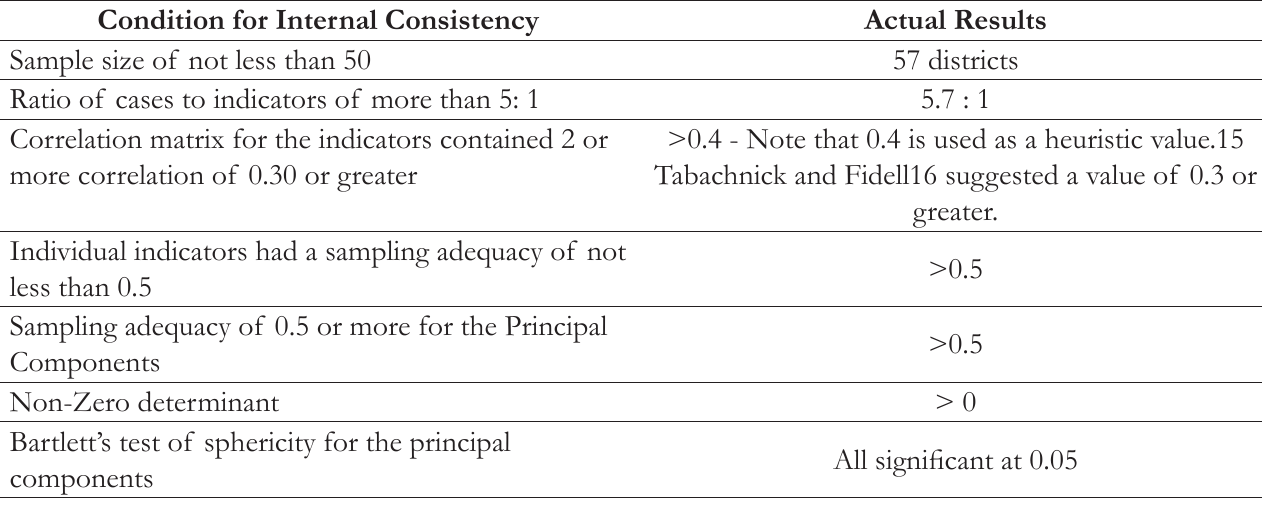
Table 3. A Comparison of Assumptive Conditions and the Actual Data for Testing for Internal Consistency Condition for Internal